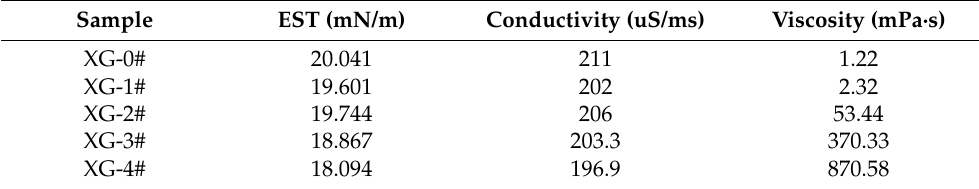
The difference between the EST values of the foam dispersions was only about 2 mN/m with the increasing concentration of XG and NPs, indicating that XG and NPs had a slight effect on the molecular interactions of FS-50/SDS at the air/liquid interface.